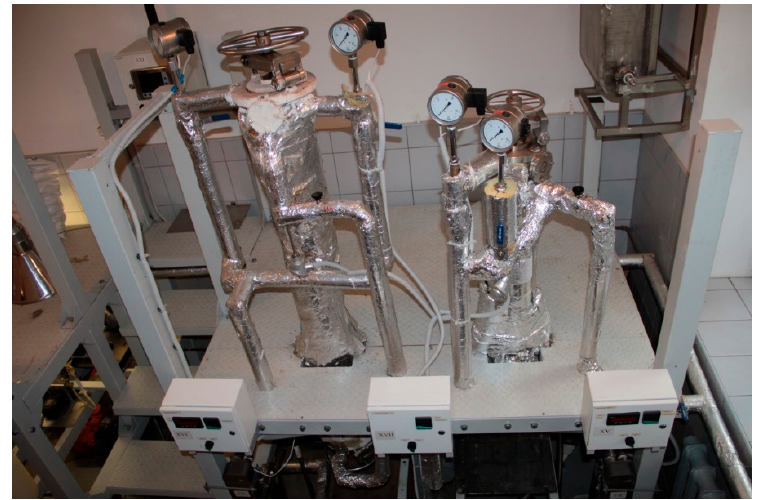
Figure 2. Bench-scale hydrolysis reactor system for obtaining 2-furaldehyde, acetic acid, and LC residue.